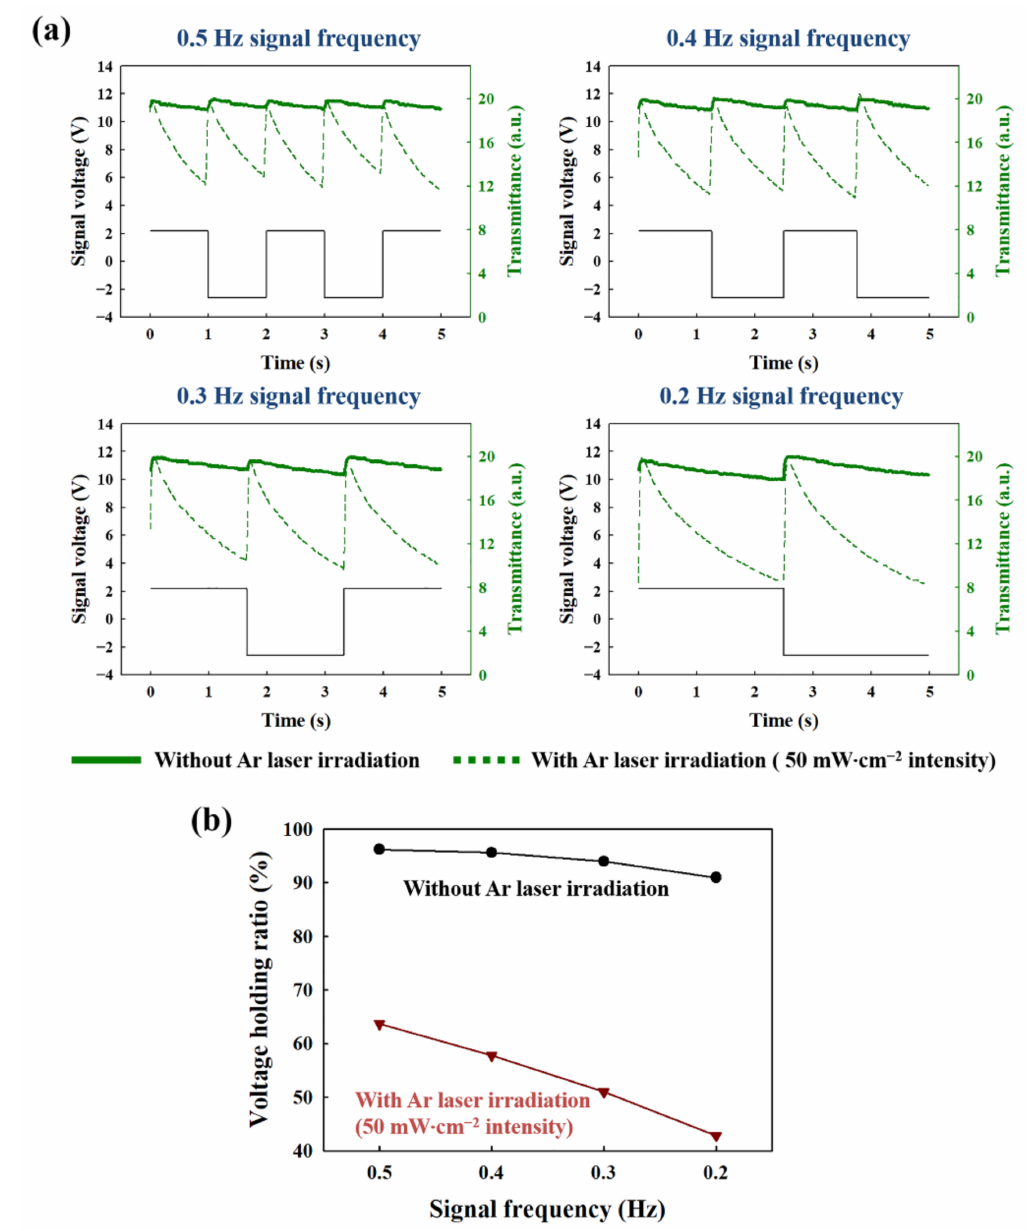
Figure 6. ( a ) Temporal transmittance properties of the FFS n -LC mode (fullerene doping density within the high- ρ PI: 0.05 wt%) under the operation frequency conditions of the applied signal voltages (solid lines: without Ar laser irradiation, dashed lines: with Ar laser irradiation of 50 mW · cm − 2 ). ( b ) VHRs extracted from ( a